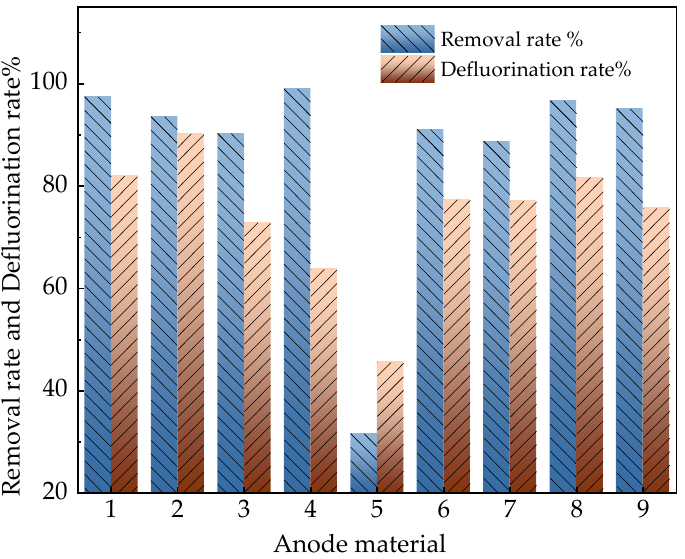
Figure 4. Removal rate of PFOA by different anodes (1-BDD, 2-Si/BDD, 3-Ti/SnO2-Sb, 4-Ti/SnO2-Sb-Bi, 5-Ti/SnO2-Sb/MnO2, 6-Ti/SnO2-Sb/PbO2, 7-Ti/SnO2-Sb/PbO2, 8-Ti/SnO2-Sb/PbO2-Ce, 9-Ti/SnO2-Sb/Yb-PbO2) [116,117].